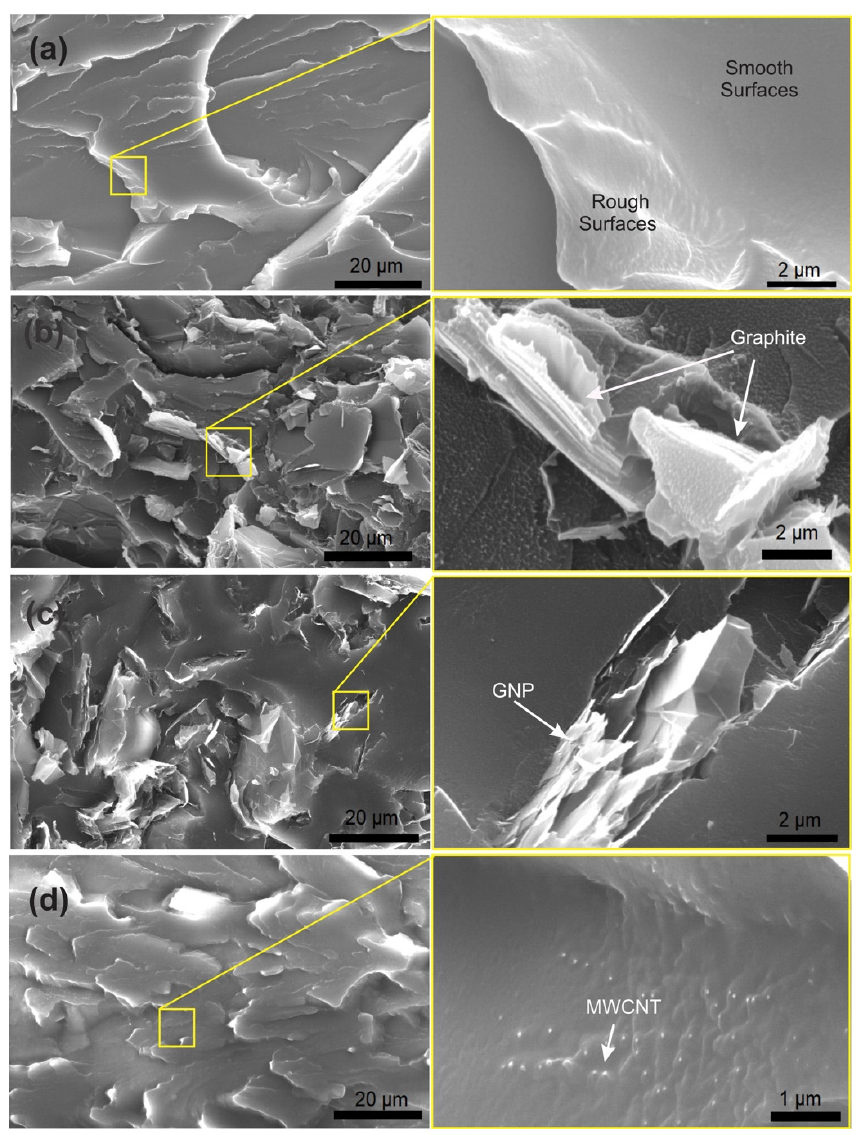
Figure 1. Fracture surface morphology with low(left) and high magnification (right) of ( a ) unfilled PET matrix, ( b ) PET/graphite microcomposites with 15 wt. % graphite, ( c ) PET/GNP nanocomposites with 10 wt. % GNP, and ( d ) PET/MWCNT nanocomposites with 0.1 wt. % MWCNT.